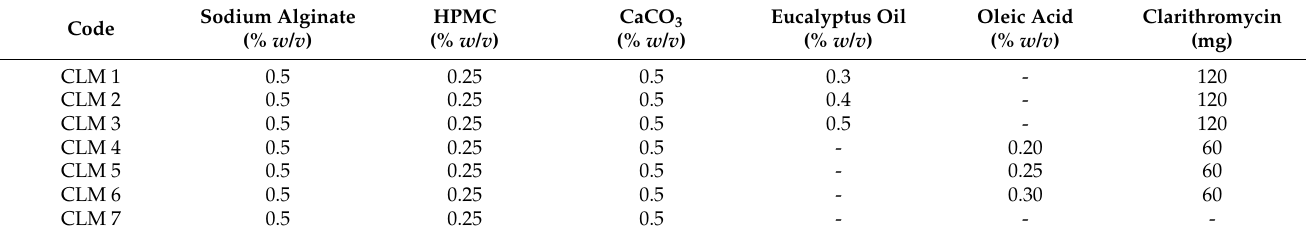
Table 1. Formulations of floating microbeads containing therapeutic oils and